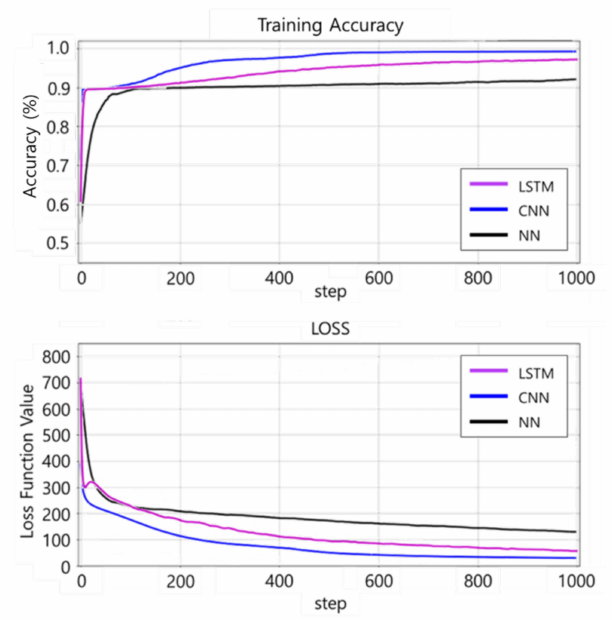
Figure 11. Training accuracy and loss. The horizontal axis of the graphs indicates the number of learning cycles.